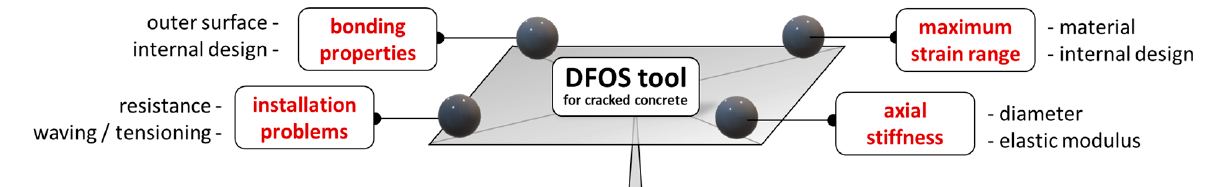
Figure 32. Issues that should be addressed while selecting the appropriate DFOS tool for monitoring the cracked concrete structures.